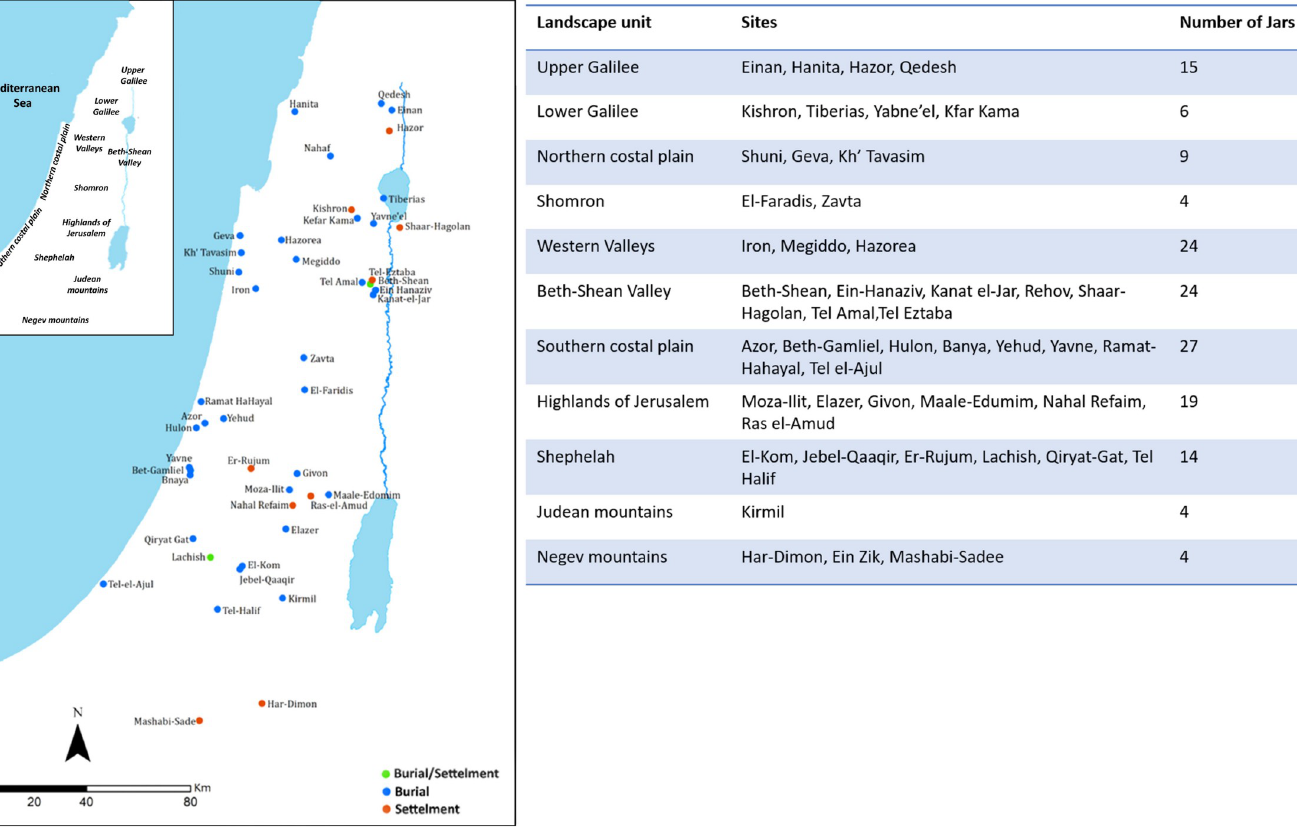
Fig 1. Distribution Map with ARCMAP of the IBA assemblages analyzed in this study (left), and the number of sites and jars per landscape unit (right). The jars’ contexts marked on the map: burial (blue dot); Settlement (red dot); and sites where jars originate from both contexts (green dot).